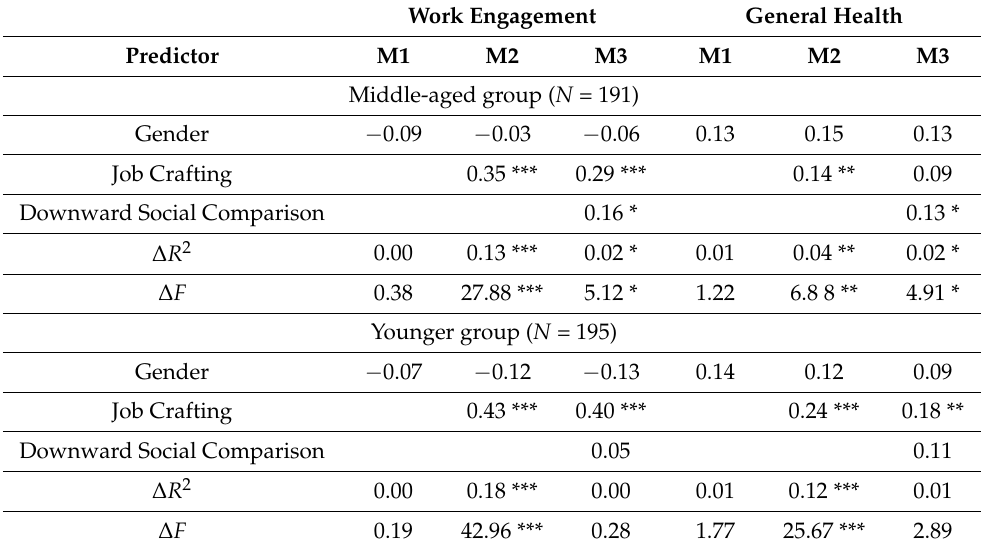
Table 7. Results from hierarchical regression analyses of Downward Social Comparison predicting work engagement and general